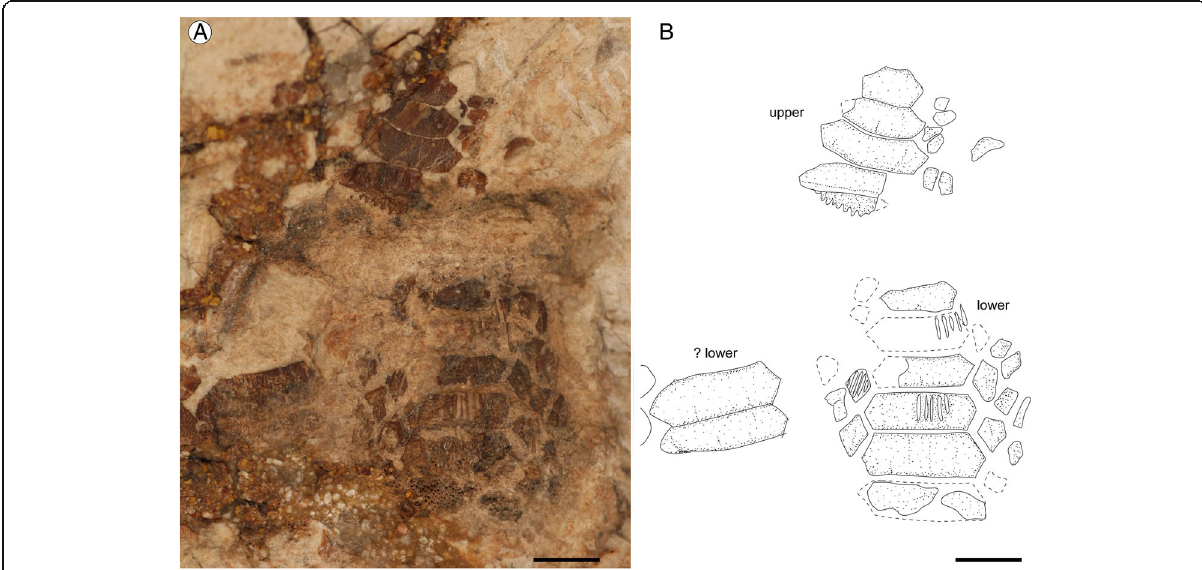
Fig. 7 Dentition of Promyliobatis gazolai from the Eocene of the Bolca Lagerstätte; specimen MSNPV 14620. a Upper and lower tooth plates. b Reconstruction. Scale bars = 5